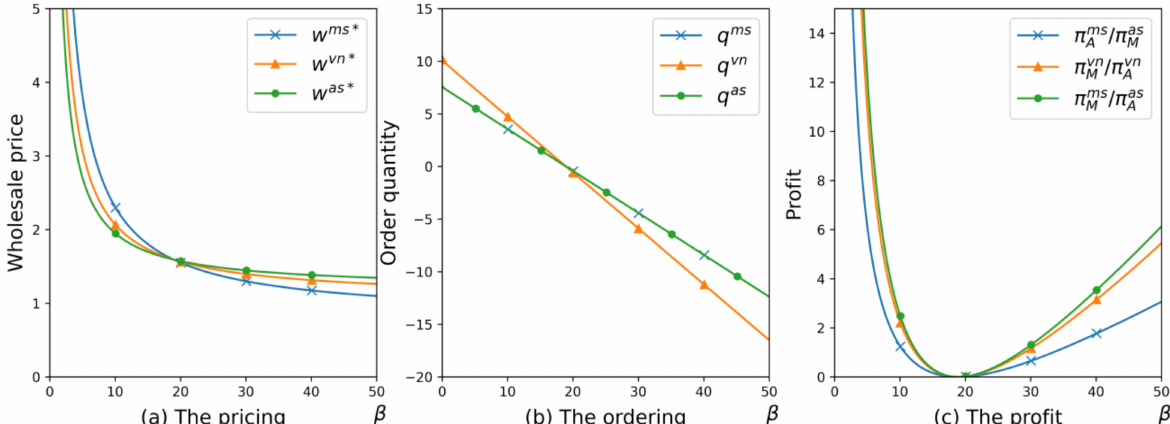
Figure 2. Impact of the consumer’s price sensitivity coefficient when the price sensitivity coefficient is low: ( a ) impact of the consumer’s price sensitivity coefficient on the pricing; ( b ) impact of the consumer’s price sensitivity coefficient on the ordering; ( c ) impact of the consumer’s price sensitivity coefficient on the profit.